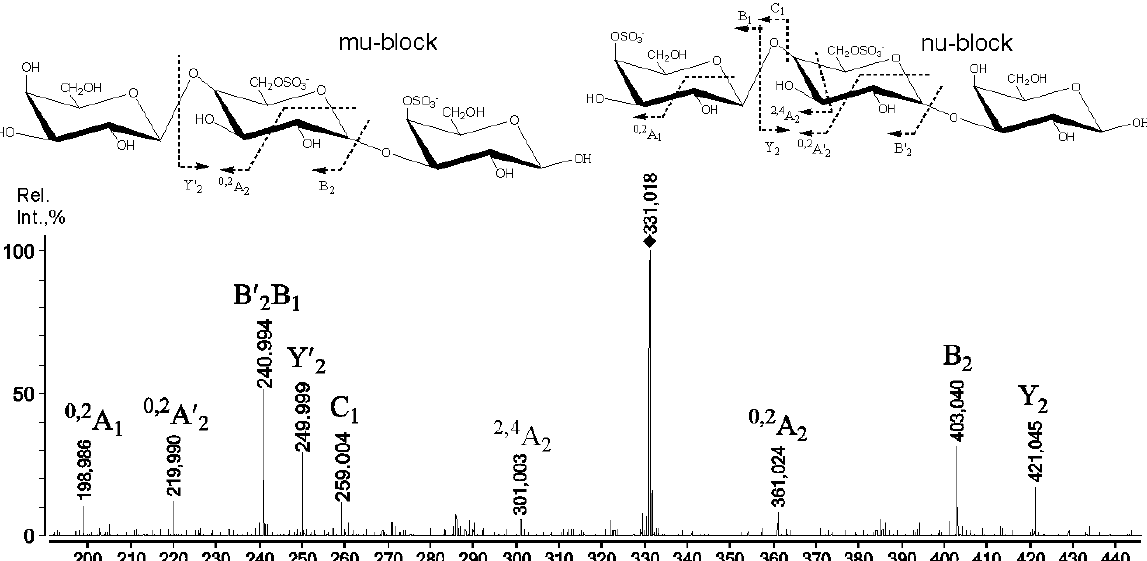
The negative-ion tandem ESIMS of the ion at m/z 331.018 (Figure 2) contained D6S residues. This was confirmed by the observation of a characteristic 0,2 X/ 0,2 A-type fragment